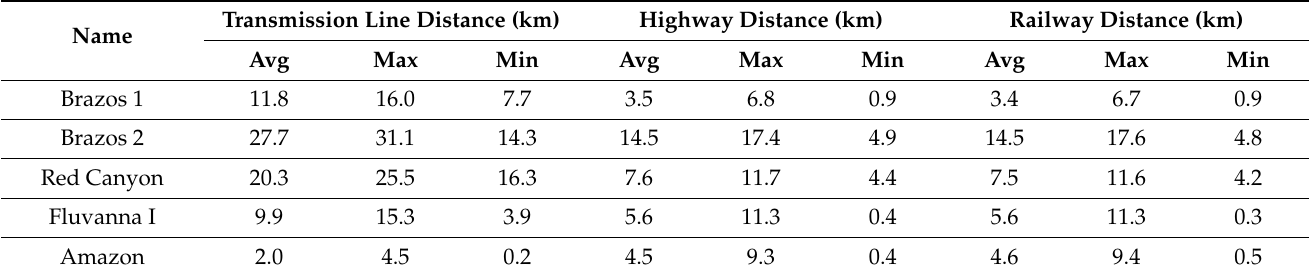
Table 4. Distance to infrastructure from the wind farm cluster in north west Texas.